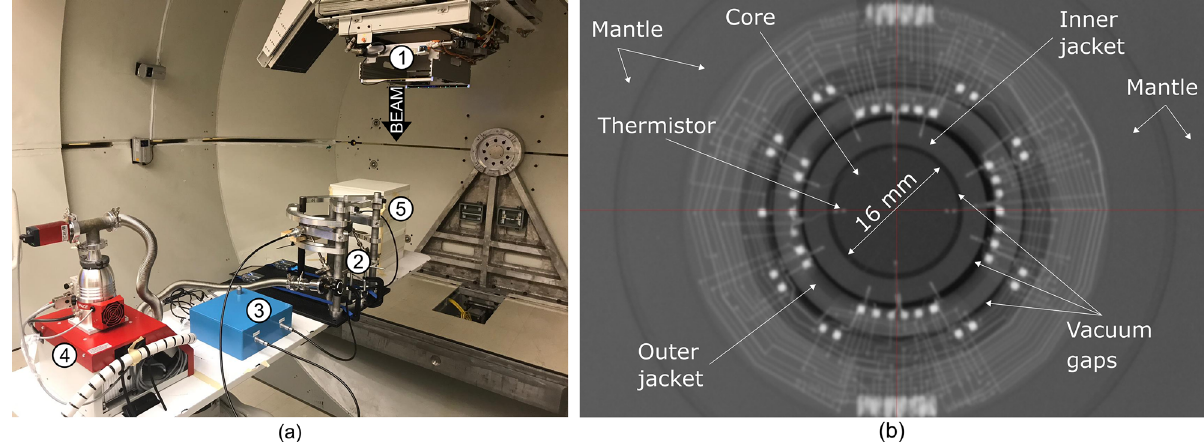
Figure 5. Experimental setup mounted on the patient couch and radiograph of the NPL PSPC. ( a ) (1) Gantry, (2) NPL PSPC, (3) measurement instrumentation for the NPL PSPC, (4) vacuum pump, (5) ionisation chamber setup. ( b ) Radiograph of the front view of the NPL PSPC 44